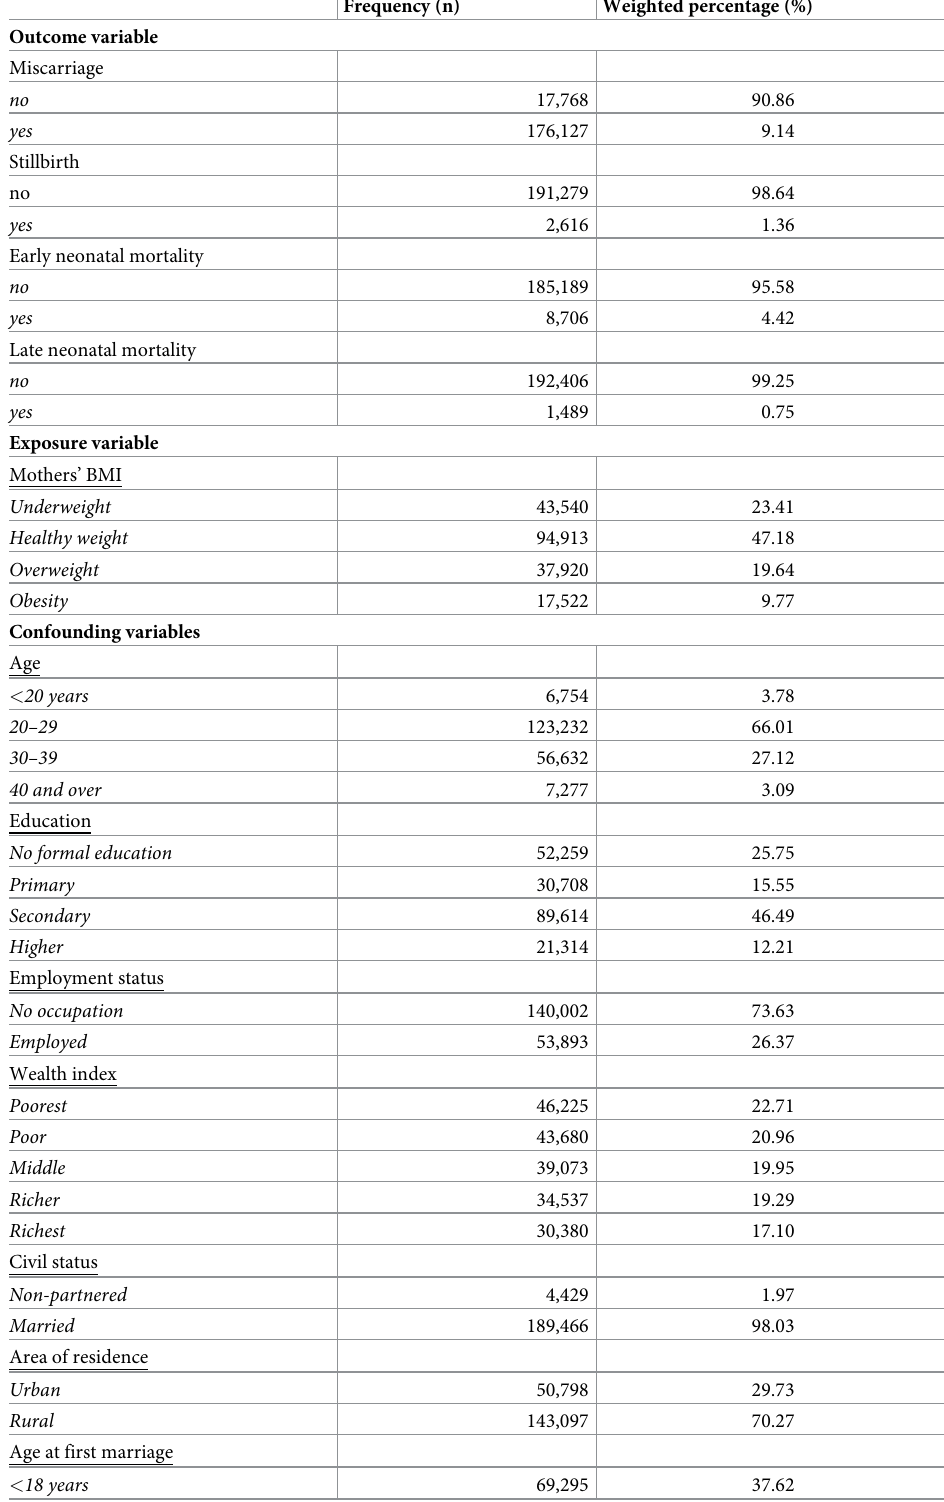
Table 1. Weighted background characteristics of the study